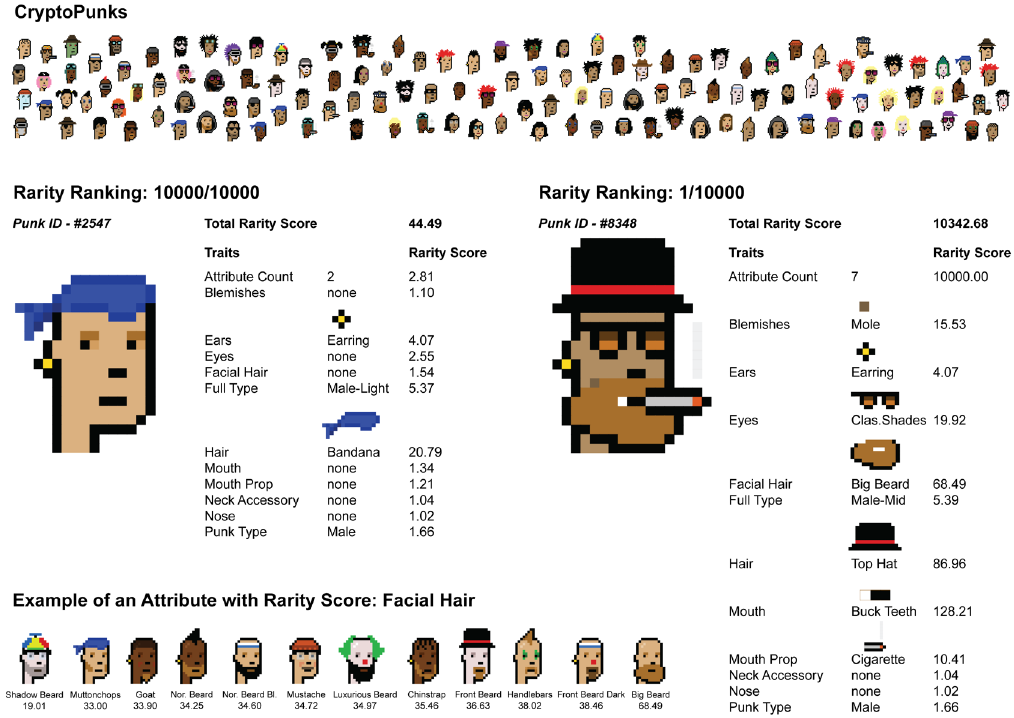
Figure 1. Illustration of rarity in a collection. Demonstration of the visual difference between rare and common NFTs using the example of CryptoPunks. CryptoPunk #2547 (on the right) is the least rare, as it has traits that appear frequently in the collection (i.e., the bandanna and the earring). CryptoPunk #8348 is the rarest in the collection, mostly since it is the only one with seven non-null attributes. Rarity scores are not normalised. After normalisation, the total rarity score for punk #2547 is zero, while the one for #8348 is 100 (min and max of the collection, respectively). In the bottom left corner, we show, as an example, the rarity score of traits associated to the “Facial Hair”